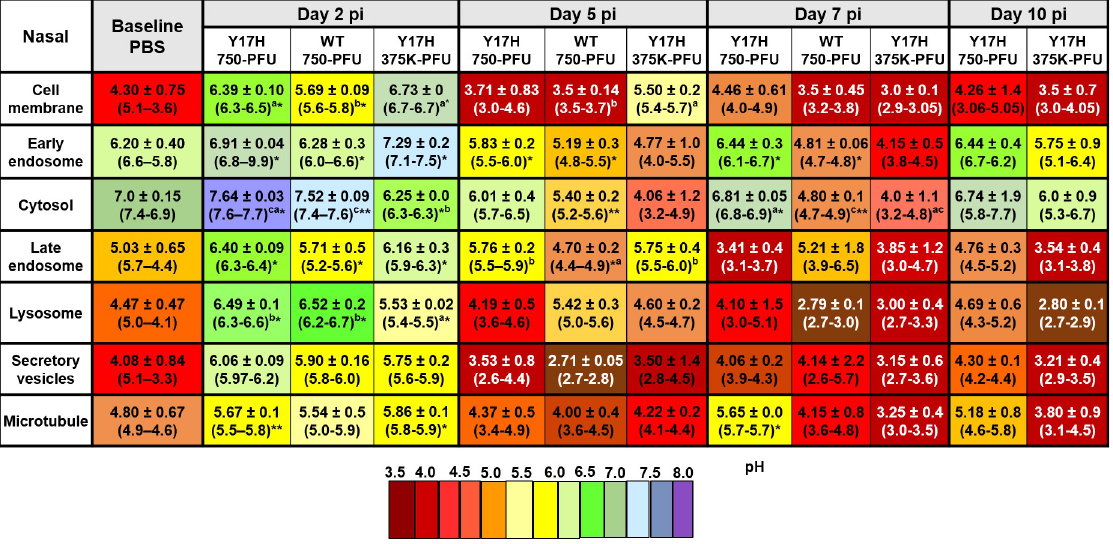
Fig 6. Intracellular pH values of uninfected (PBS) and infected live epithelial cells isolated from the nasal tissues of DBA/2J mice. Mice were intranasally inoculated with PBS, WT virus (750 PFU), or Y17H virus (750 or 375,000 PFU). After 2, 5, 7, or 10 days of infection, following the previously reported extracellular pH measurements, single epithelial cells from a homogenate of three mice per group were isolated and analyzed with high-throughput flow cytometric analyses. A panel of the following pH dyes with different wavelengths included Oregon Green DHPE for phospholipid cell membrane pH, pHrodo Red succinimidyle (NHW) ester conjugated with an EE1 antibody as a marker of early endosomes; pHrodo Red AM for cytosolic pH; pHrodo Green STP ester conjugated with RAB7 as a marker of late endosomes; and LysoSensor Blue as a marker of lysozomes. A pHrodo Red succinimidyle (NHW) ester conjugated with a GRP94 monoclonal antibody was used as a marker of the secretory vesicles. Paclitaxel Oregon Green 488 was used as a pH marker of microtubules. Values are mean ( ± SD) and ranges of the homogenates of three mice from two indepenant experiments. Data were calculated from a linear standard curve generated from an intracellular pH calibration kits for each probe with Graph Pad Prism 7 (GraphPad). After calculating all fitted data, two way-ANOVA and Tukey posthoc tests for two independent experiments were performed separately for each time point. Statistically significant differences for virus-infected groups compared to the PBS group are indicated as follows: � P < 0.5, ��� P < 0.01, ��� P < 0.001, and ���� P < 0.0001. At each time point, statistically significant differences between the three virus-infected groups are denoted by having a different lower-case letter (a, b, or c) superscript ( P = 0.001). Values with the same lower-case letters indicate no significant statistical difference between those